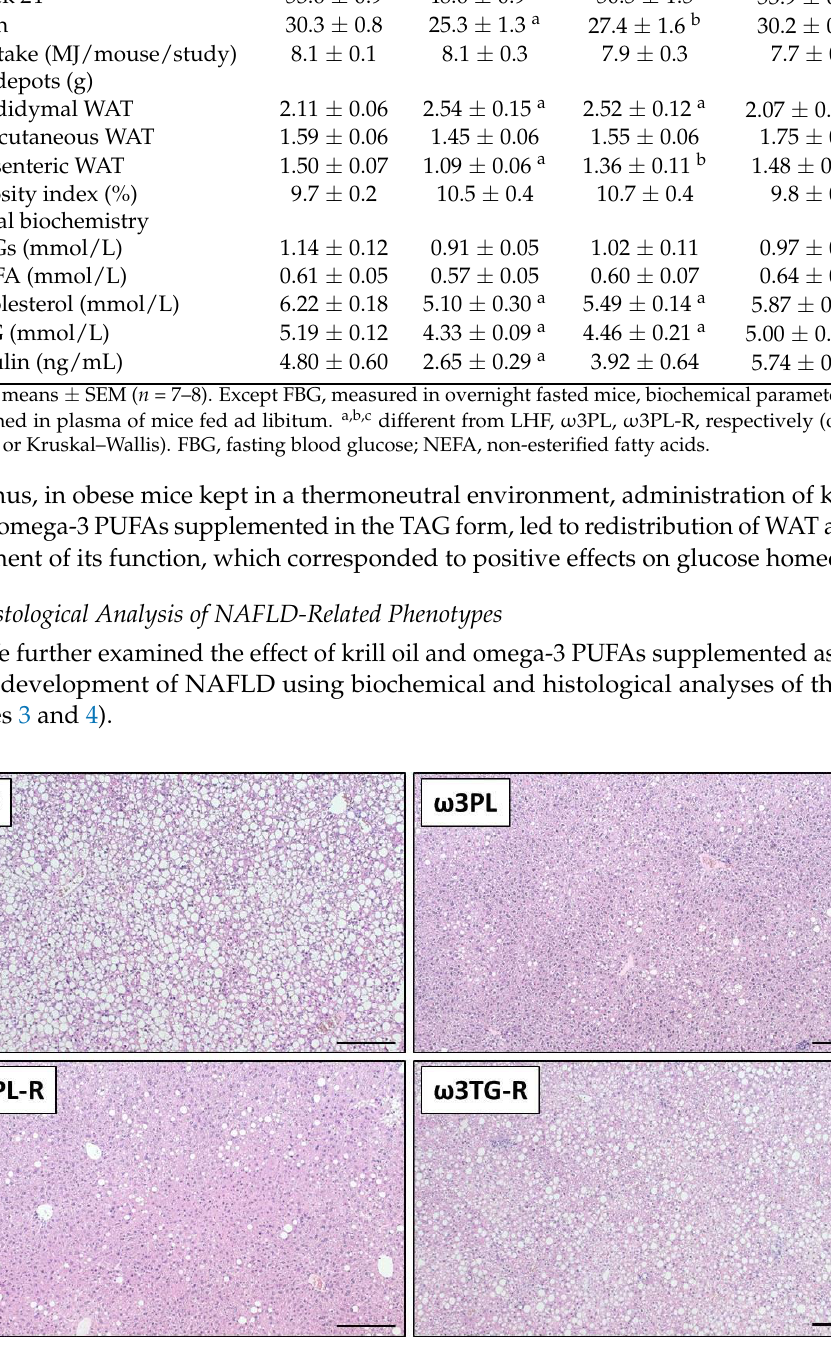
Figure 3. Representative histological sections of liver stained with hematoxylin and eosin. Bars = 200 µm.